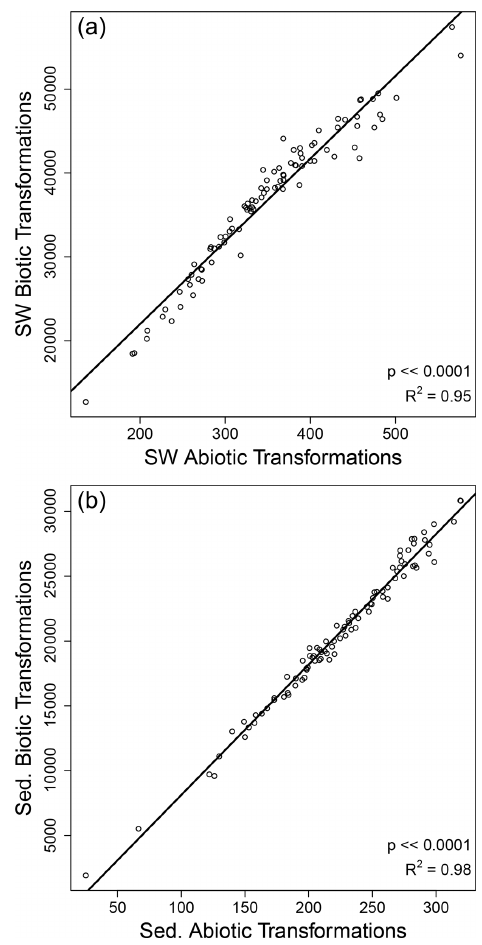
Figure 5. Strong correlations were observed between the number of biotic and abiotic organic matter transformations within surface water (SW) and within sediment (Sed.). Each circle represents one sampled site for surface water (a) and sediments (b) . The solid black line is the regression model, and statistics are provided in each